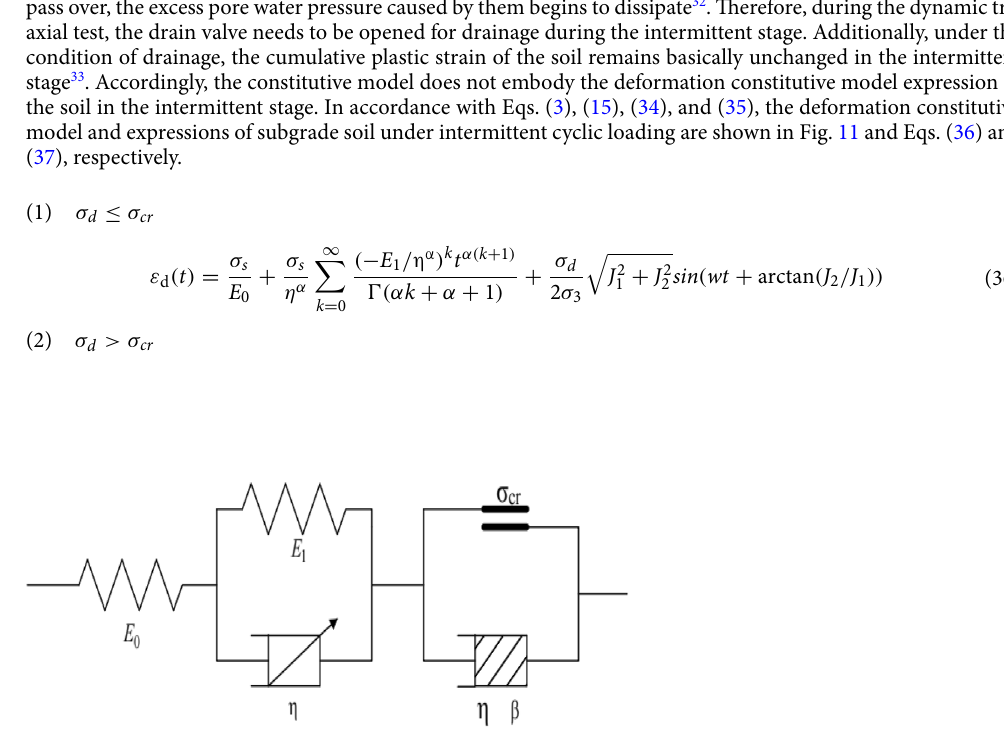
Figure 11. Deformation constitutive model of soil under intermittent cyclic